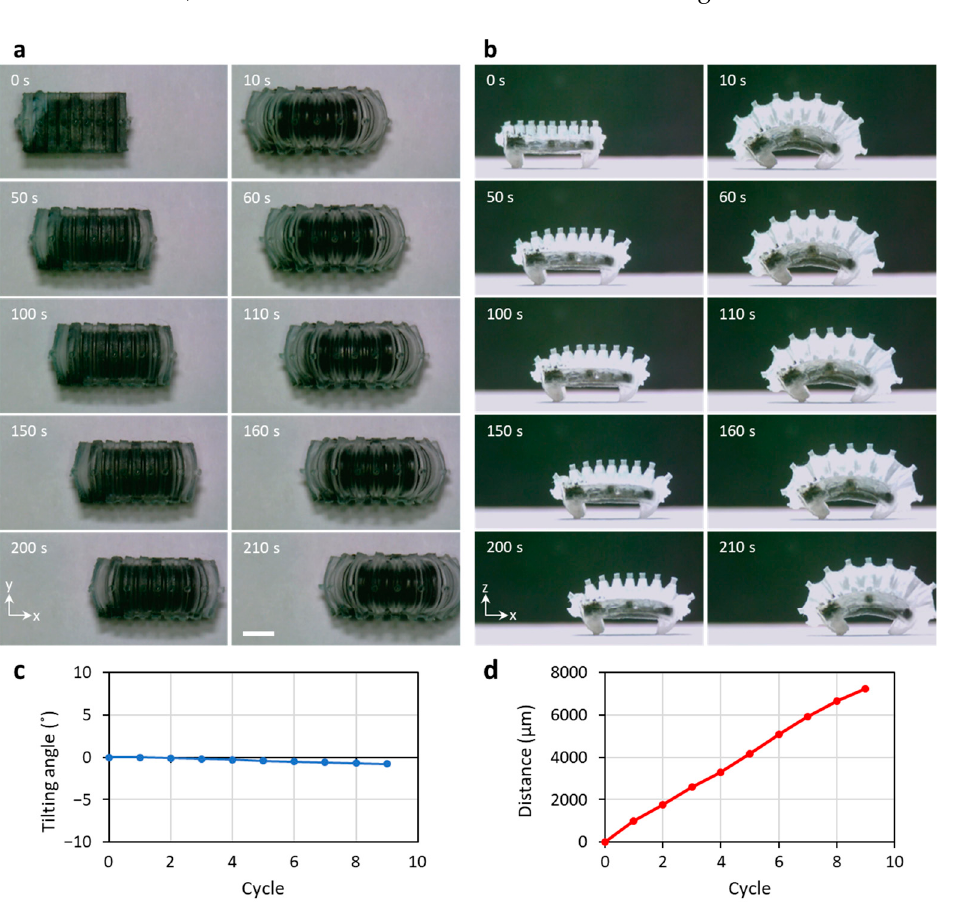
Figure 7. Demonstration of crawling based on repetitive motion of the WIBot. ( a ) Top view to check the WIBot is crawling in a straight line. ( b ) Side view to measure displacement of the WIBot. The scale bar represents 2 mm. ( c ) The tilting angle and ( d ) the moving distance according to repeated operation.